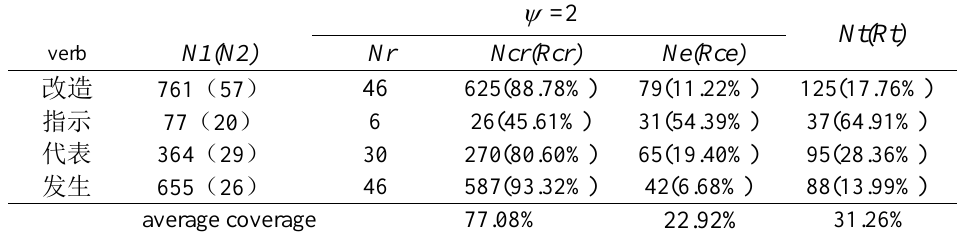
Table 4. Experiment data in learning